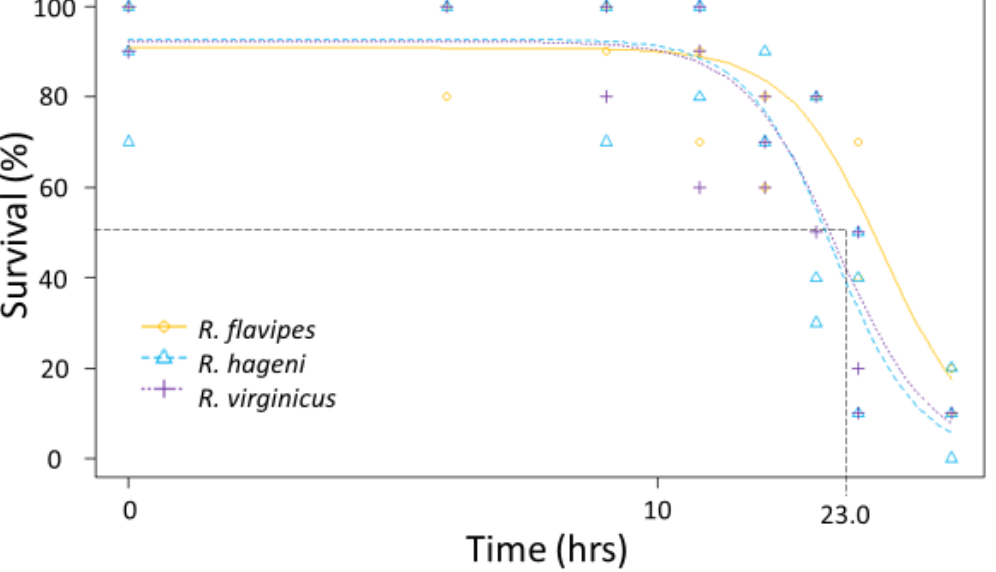
Figure 4. Submersion tolerance for multiple colonies of Reticulitermes flavipes , R. hageni , and R. virginicus . Lethal time 50% (LT 50 ), or the time at which 50% of individuals died from submersion is indicated by the dashed line. The x axis is log- scaled.